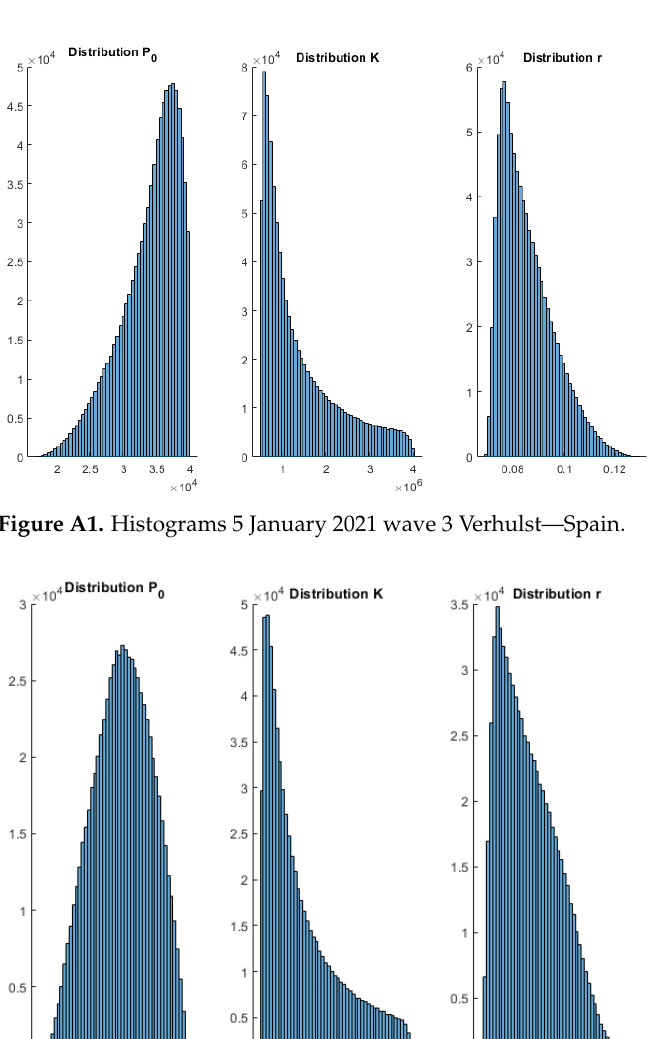
Figure A4. Histograms 25 January 2021 wave 3 Verhults — Spain.